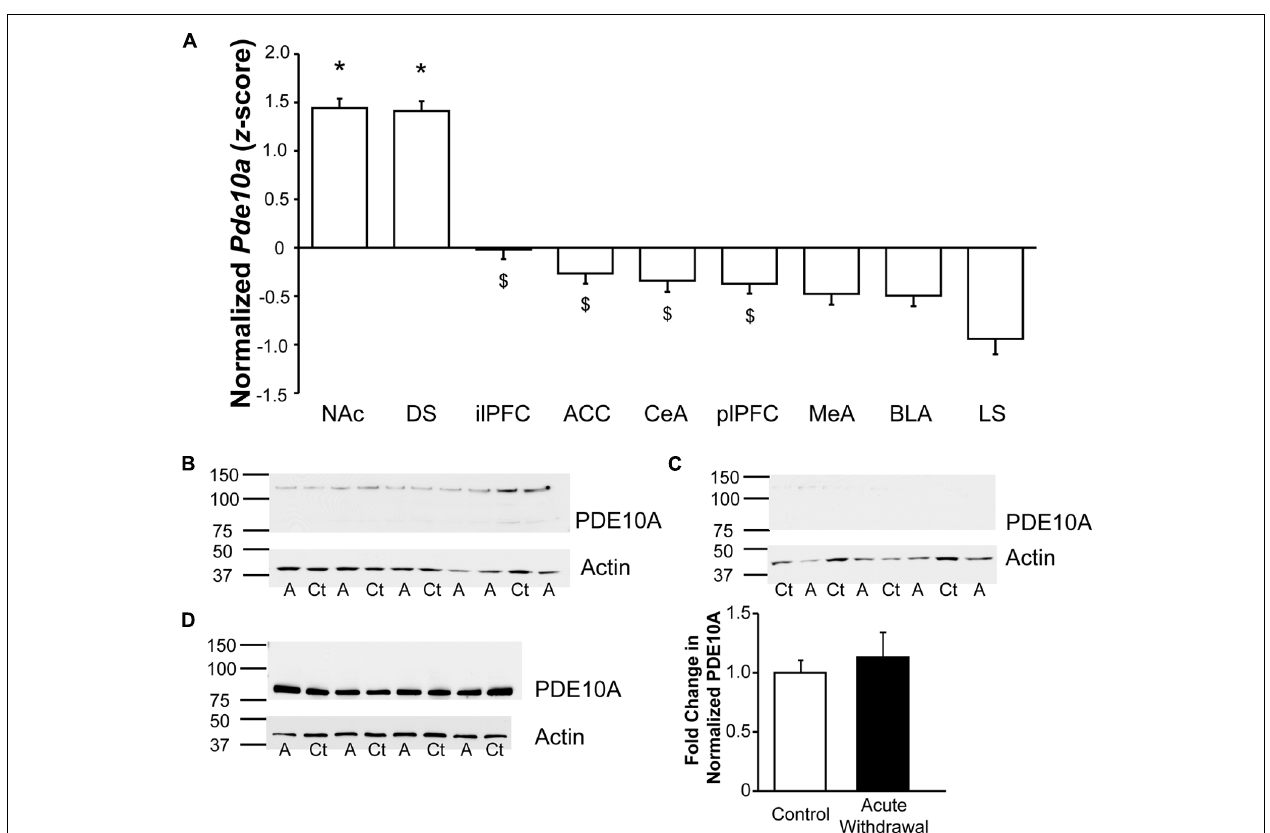
FIGURE 4 | Significant enrichment in striatal Pde10a expression relative to other stress- and reward-responsive brain regions. (A) Quantitative analysis of regional Pde10a mRNA expression in alcohol-naïve controls demonstrated very significantly lower Pde10a expression in medial prefrontal and amygdala subdivisions, as compared to the striatal regions (DS, NAc). Of the extrastriate regions assessed, infralimbic prefrontal cortex demonstrated the highest and lateral septum the lowest levels of Pde10a mRNA in alcohol-naïve control rats. NAc, nucleus accumbens; DS, dorsal striatum; ilPFC, infralimbic prefrontal cortex; ACC, anterior cingulate cortex; CeA, central amygdala; plPFC, prelimbic prefrontal cortex; MeA, medial amygdala; BLA, basolateral amygdala; LS, lateral septum. Data are presented as least squares means ± standard error of z -score transformed Pde10a covaried for Cyp expression levels. * p < 0.05 vs. extrastriatal regions, $ p < 0.05 vs. lateral septum; n = 21–24 per region. (B–D) PDE10A protein levels, as